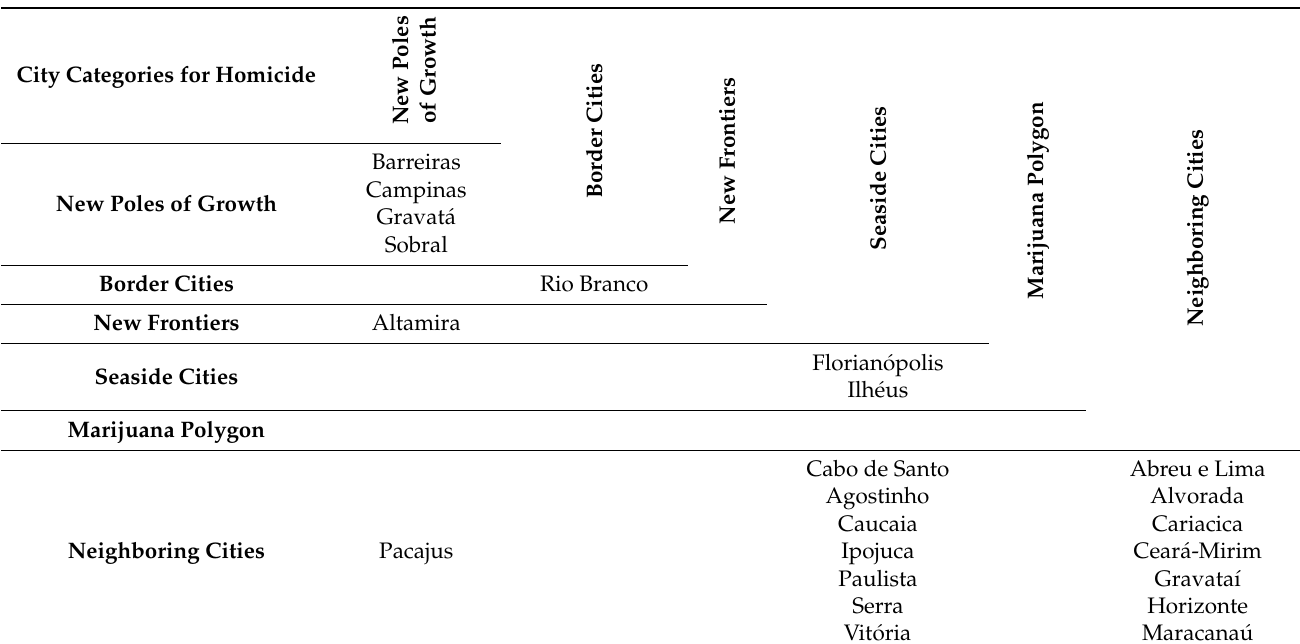
Table 6. Emerging problematic cities that significantly accounted for the equivalent national increase in homicides in Brazil.